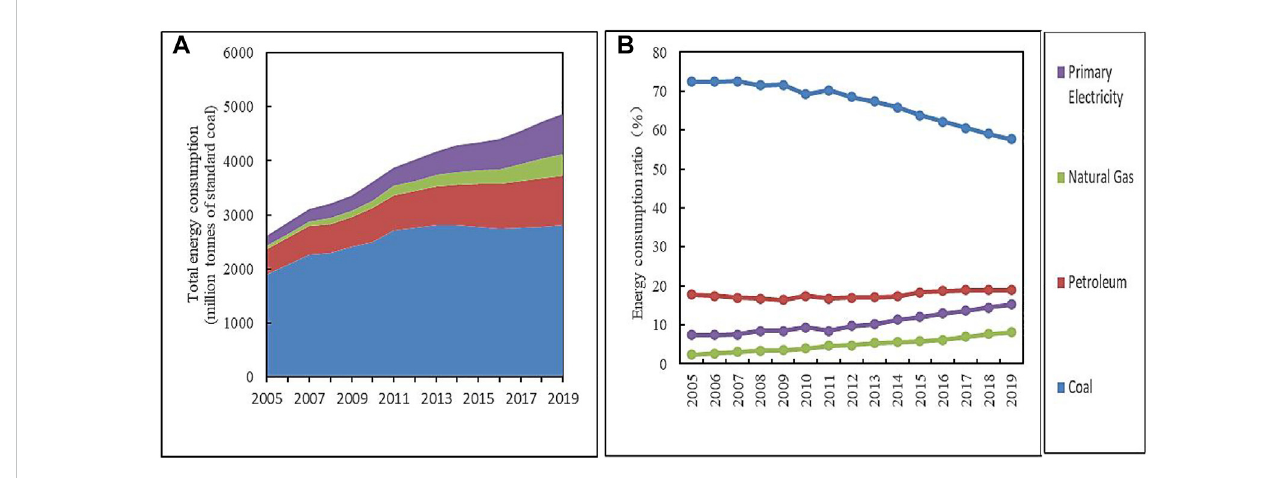
FIGURE 1 China ’ s Total energy consumption (A) and energy consumption ratio (B) during 2005 – 2019. Data source: China Statistical Yearbook